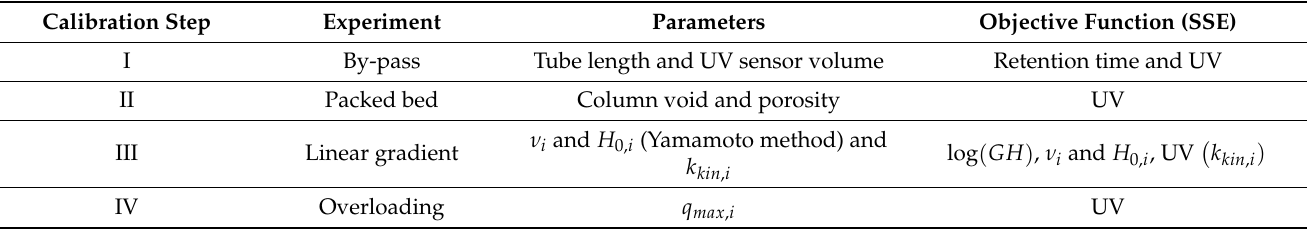
parameters, and objective